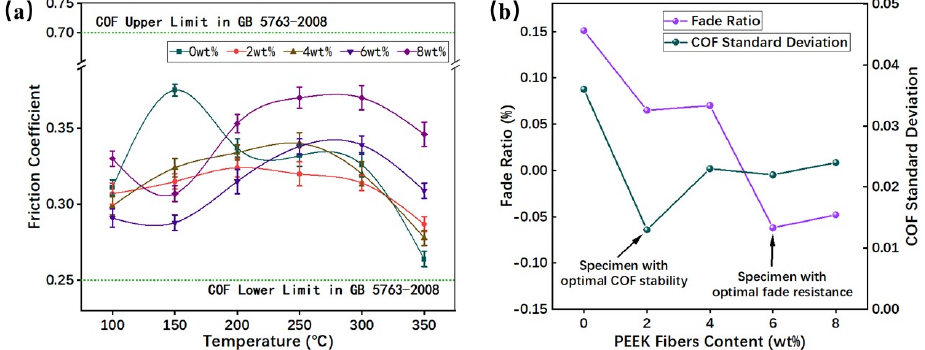
Figure 6. COF of the fade test: ( a ) COF at each temperature, ( b ) Fade ratio and COF Standard De- viation.